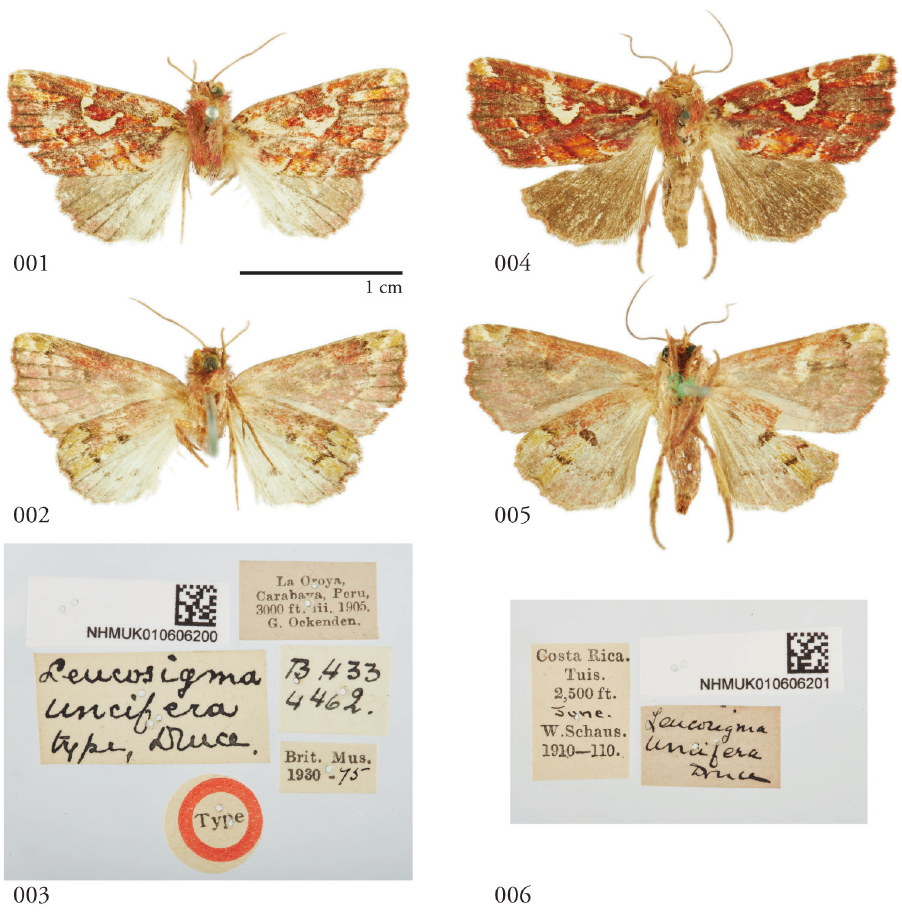
Figures 1–6. Dorsal and ventral habitus and labels of of Leucosigma uncifera. (1–3) Holotype ♂ ,